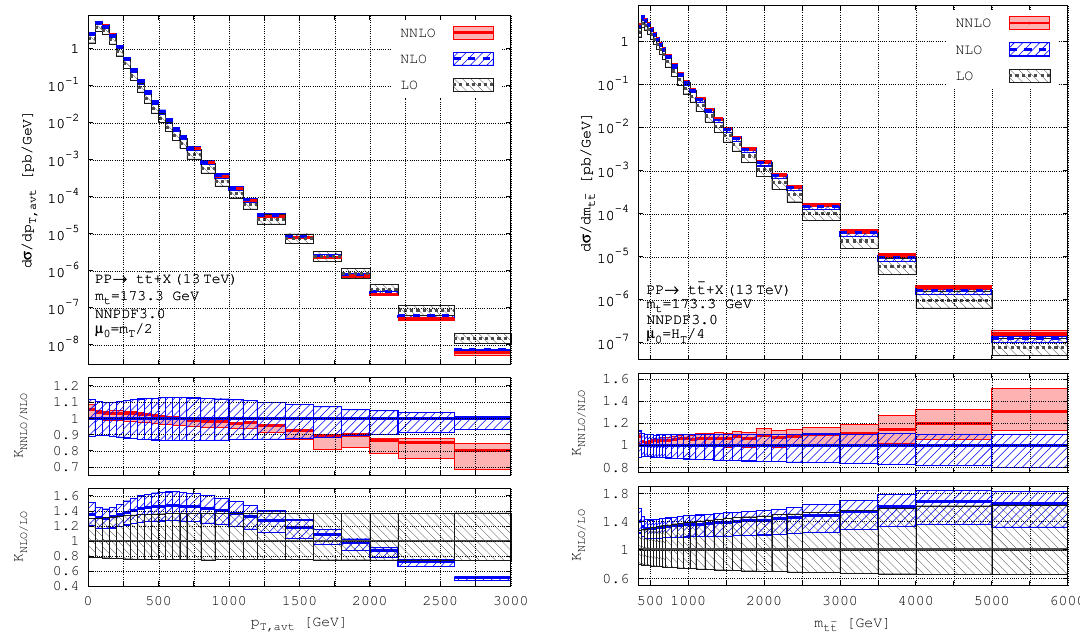
Figure 14 . The p (left) and m (right) distributions for LHC 13 TeV. Error bands are from T;t= (cid:22) t t (cid:22) t scale variation only.